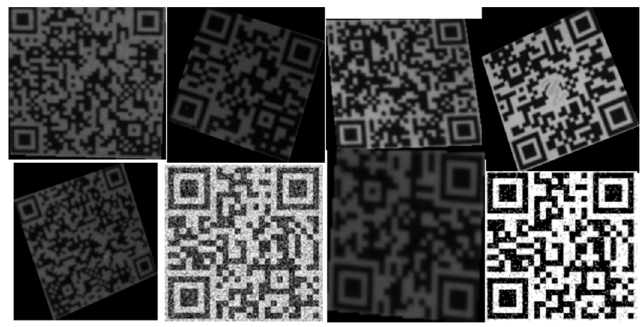
Figure 8. Partial samples for UNet training.